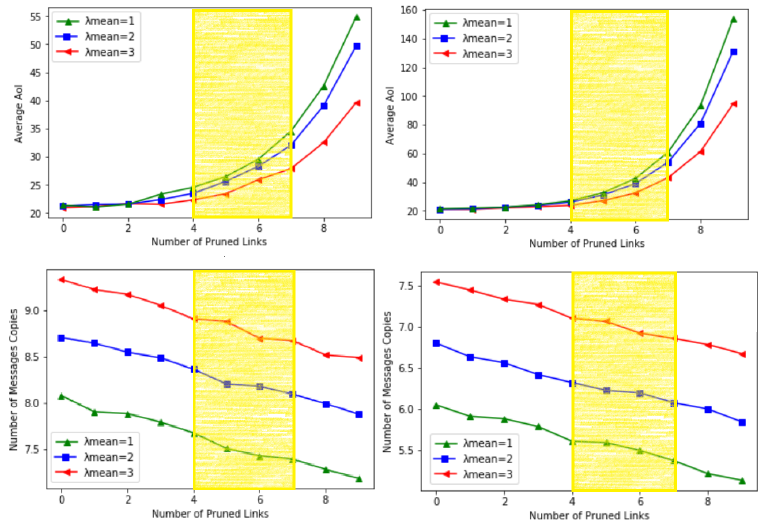
Figure 10. The simulation results from running the pruning algorithm on the high-clustered topology when µ = 1. The left column is the result after running the algorithm when σ = 1 and the right column is the result after running the algorithm when σ = 2.